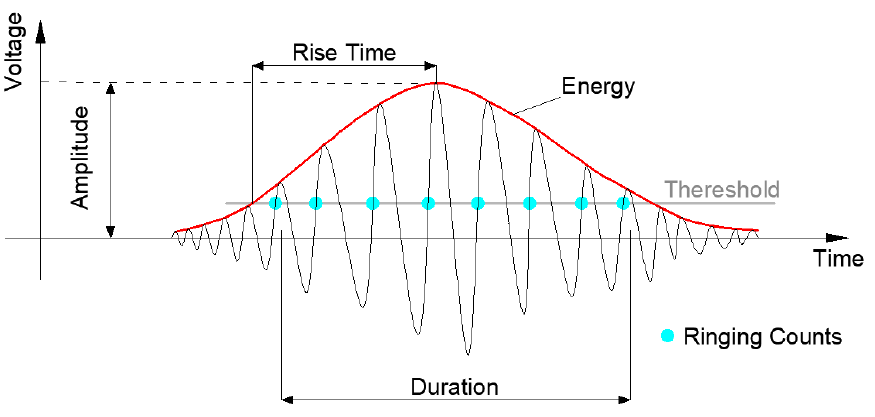
Figure 1. Typical AE signal.